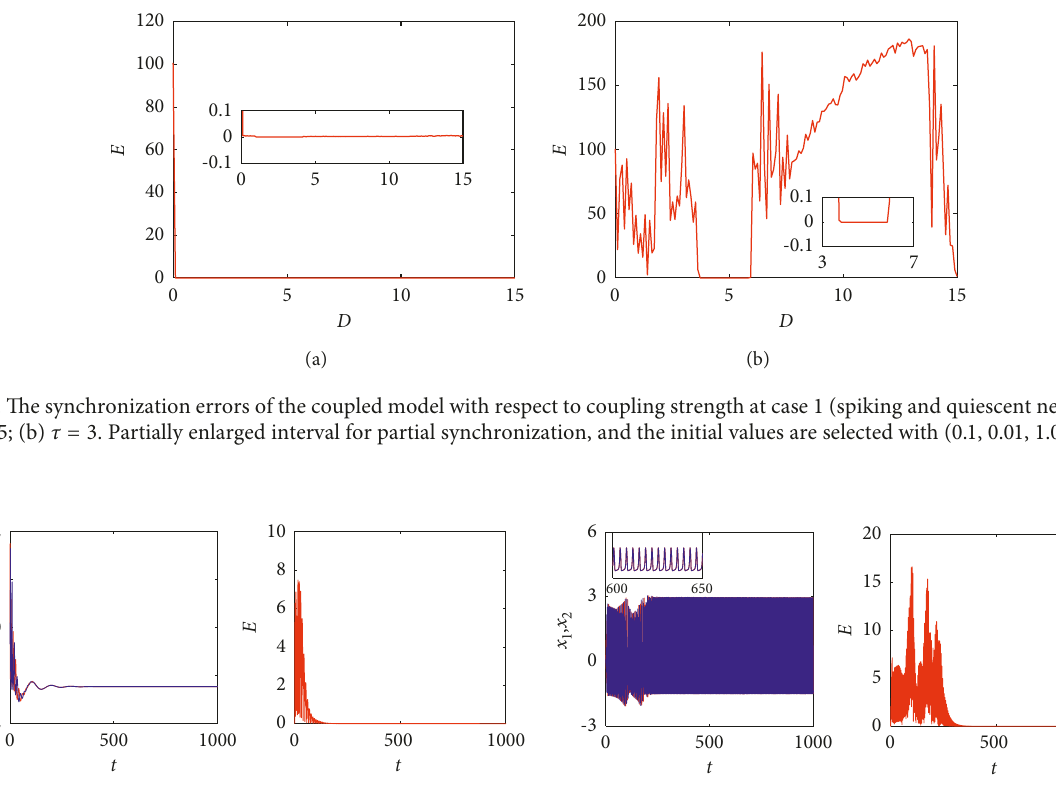
(red line) and x (blue line), and error functions of the coupled model at case 1 (spiking 1 2